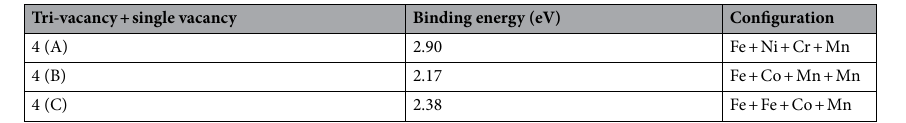
Table 3. Binding energies of the tetra-vacancy cluster composed of a single vacancy and a tri-vacancy with different atomic vacancy formation sequences.